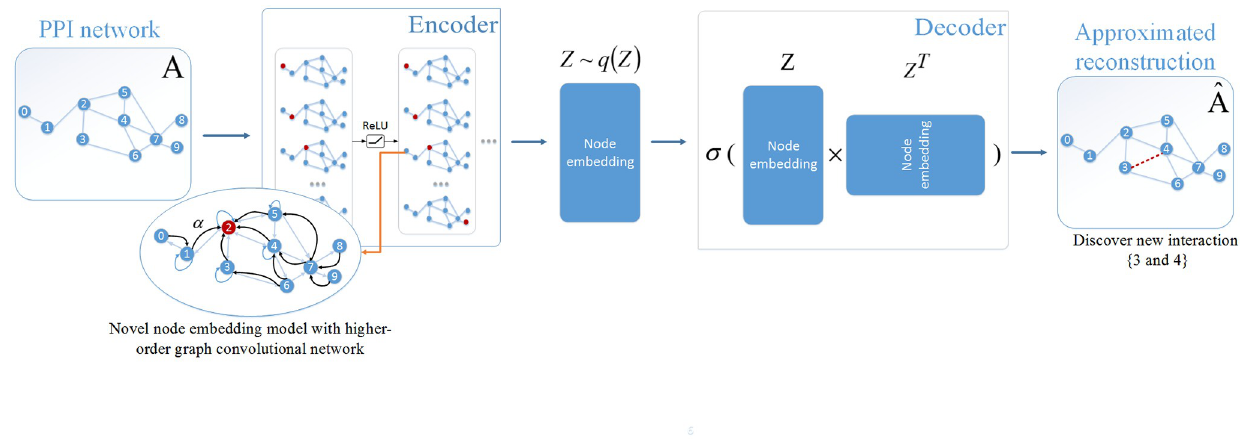
Fig 2. The basic framework of the higher-order GCN variational auto-encoder model to predict new PPIs.